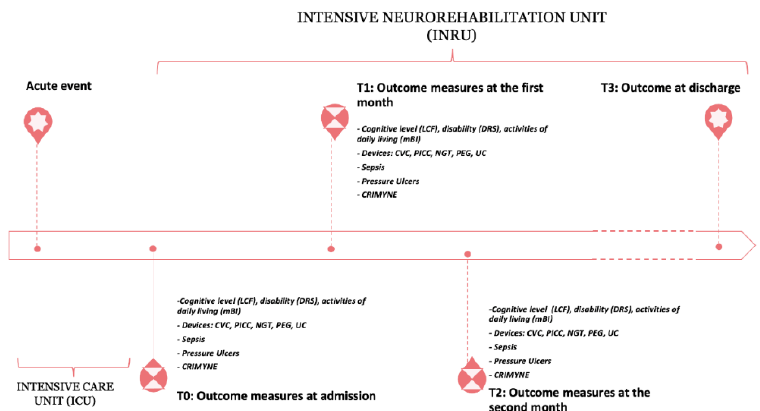
Figure 1. Detailed experimental protocol and timeline of the study. LCF = Levels of Cognitive Functioning Scale; eight ratings levels (from no response to appropriate response), with a good test–retest and inter-rater reliability and concurrent and predictive validity. DRS = Disability rating scale; a 30-point scale and 8-item measure providing information on the level of disability of patients with sABI. mBI = modified Barthel Index; a 10-item instrument measuring functional independence in personal activities of daily living. Presence of devices (yes/no): CVC = central venous catheter; PICC = peripherally inserted central catheter; NGT = nasogastric tube; PEG = percutaneous endoscopic gastrostomy; UC = urinary catheter. Sepsis (yes/no). CRYMINE = critical illness myopathy and/or neuropathy (yes/no).